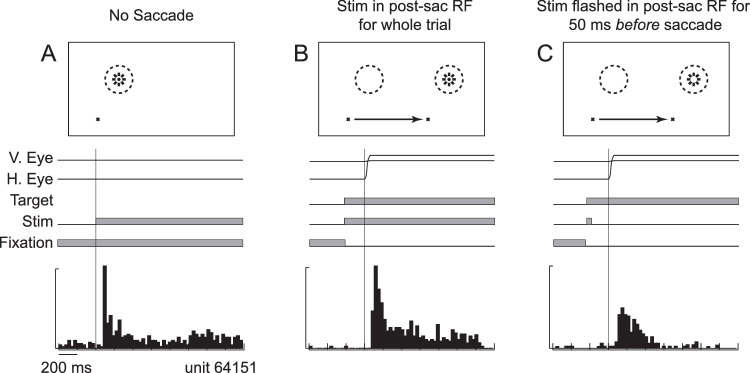
Remapping of predictive activity in a single LIP neuron. (A) The response of the neuron to a stimulus (Stim) presented in its response field (RF) during fixation, aligned by stimulus onset. (B) The response of the neuron to a stimulus brought into the postsaccadic RF by a saccade, aligned by saccade onset. (C) The response of the neuron when the location of a flashed stimulus was brought into the postsaccadic RF by a saccade, aligned by saccade onset. This response represents the remapping of the persistent activity to the flashed stimulus. The time course of the trials is shown in the middle of each panel. Modified from Duhamel, Colby, and Goldberg (1992) with permission.